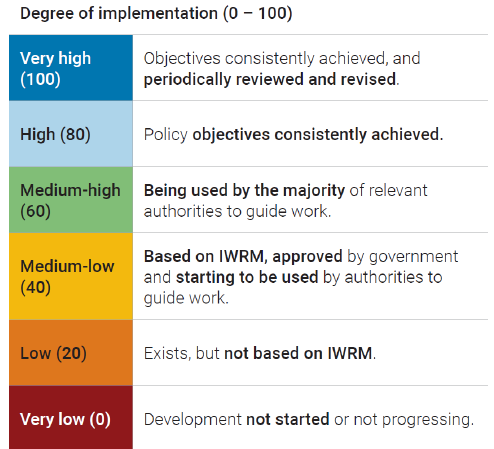
Figure 3. Example of descriptive thresholds from Sustainable Development Goal (SDG) indicator 6.5.1